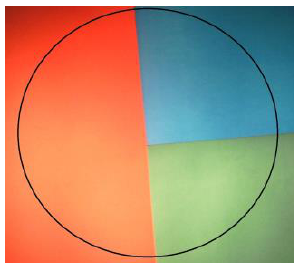
Figure 2: A general view of the paper sheets